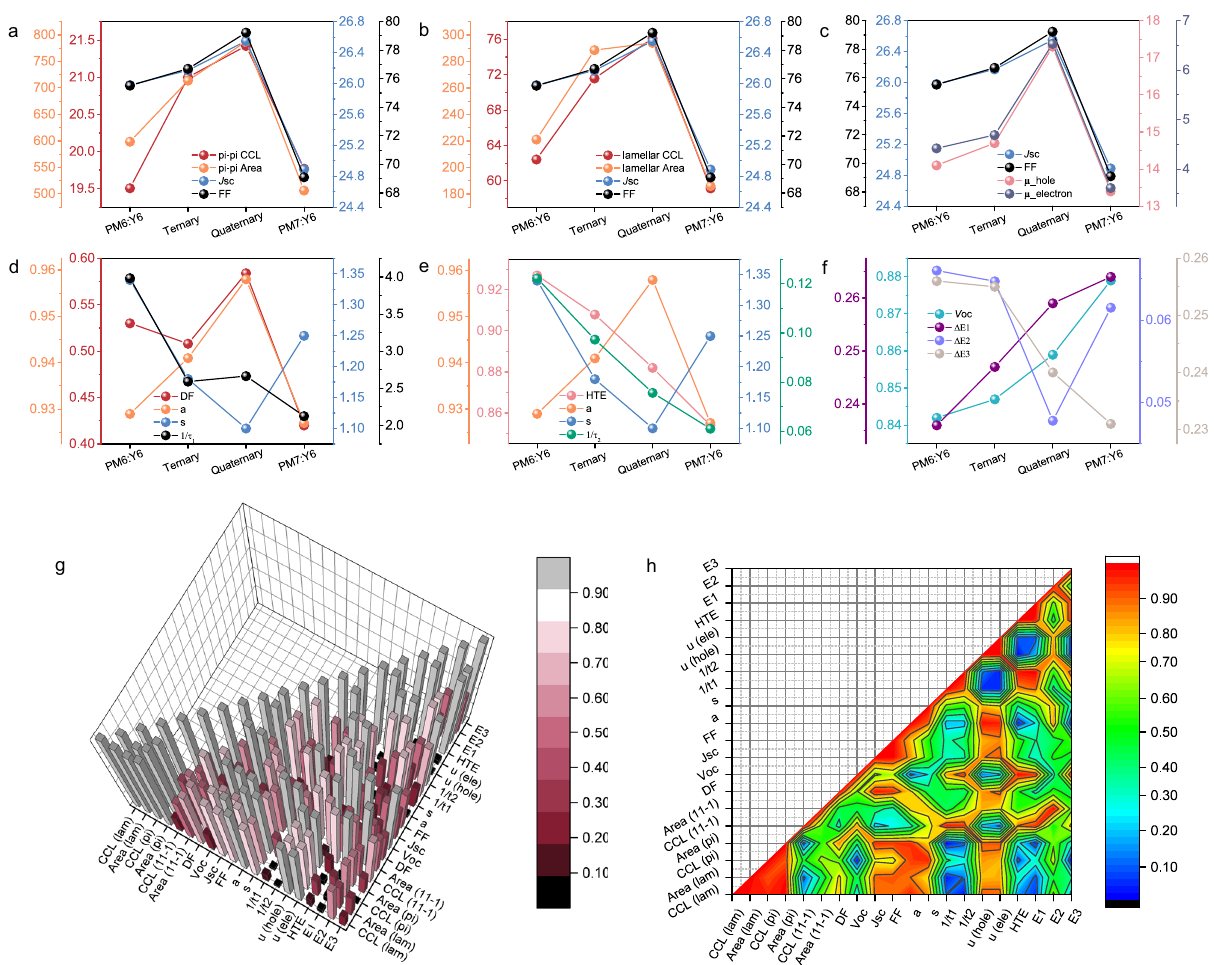
Fig. 5 Correlation of structure, photon-to-electron process, and device performance. a – f Multidimensional correlation analysis of structure – property relationships (the parameter units are following previous data). g , h Person correlation analysis of major device and structure parameters (color bar and height both represent person correlation coef fi cients, CCL is the abbreviation of crystal coherence length, DF is the abbreviation of driving force, HTE is the abbreviation of hole transfer ef fi ciency, E1 – E3 represent energy